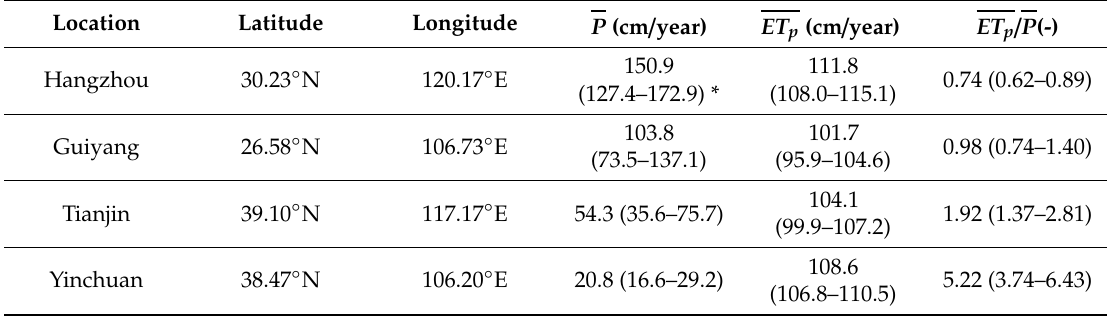
Table 1. Mean annual precipitation ( P ), potential evapotranspiration ( ET p ), and aridity index ( ET p / P ) at the study